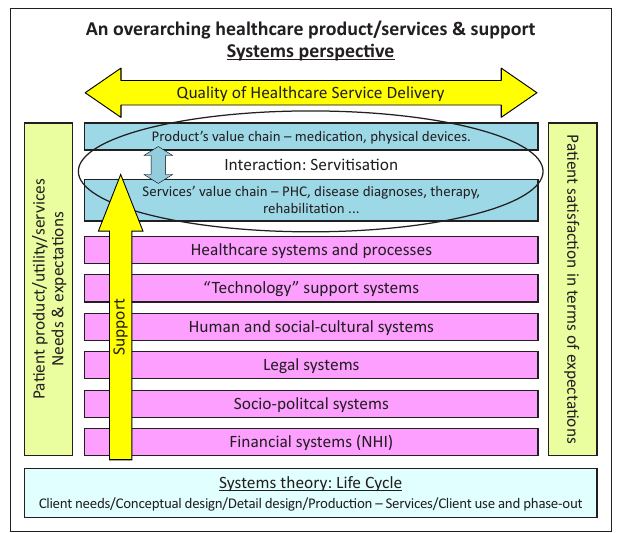
FIGURE 1: A healthcare systems management